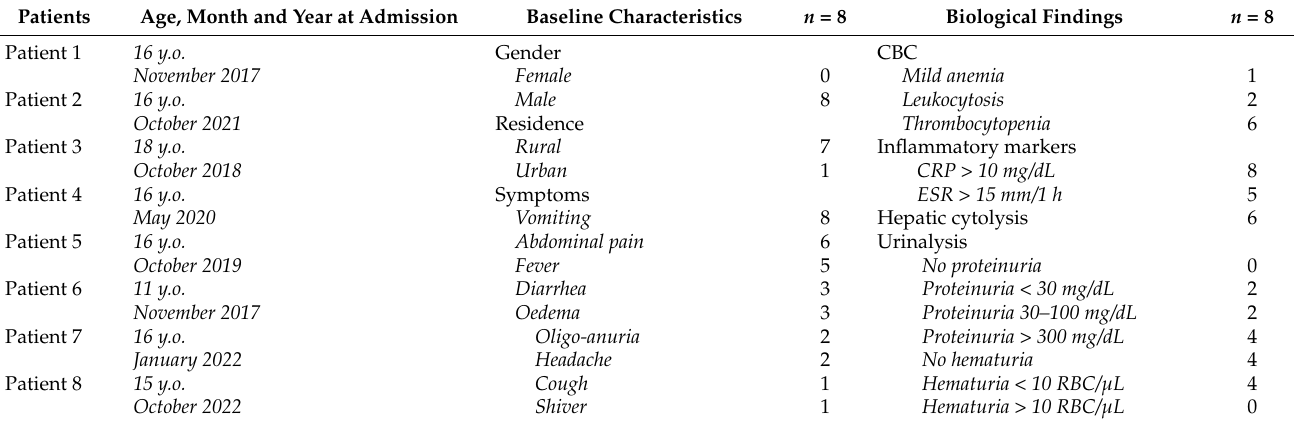
Table 1. Sociodemographic, clinical characteristics, and biological findings at baseline.